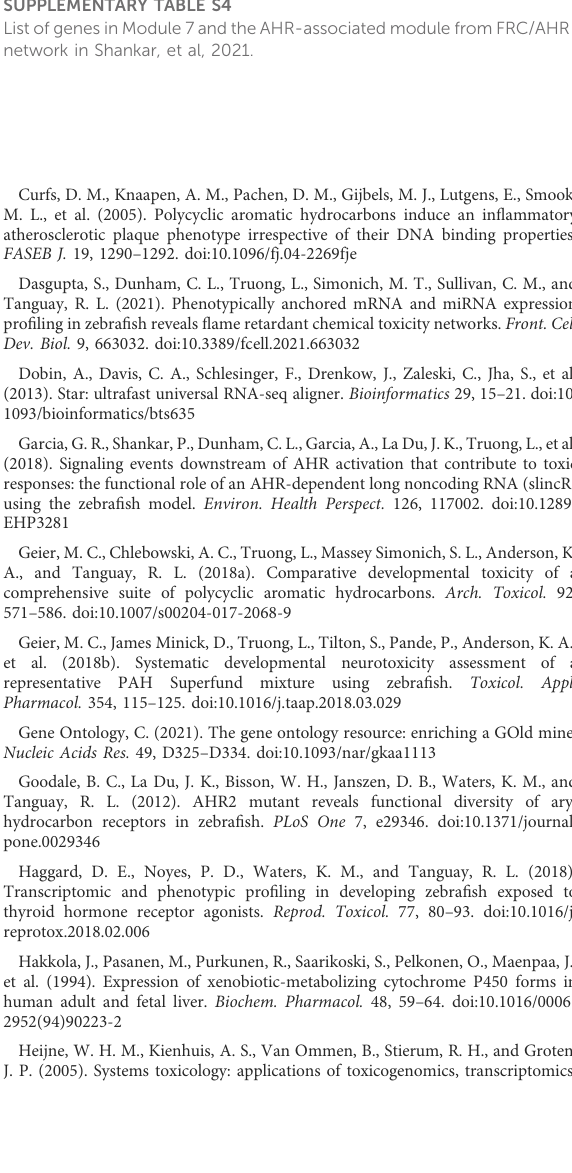
SUPPLEMENTARY TABLE S1 Description of morphological endpoint binning. SUPPLEMENTARY TABLE S2 All morphology data. SUPPLEMENTARY TABLE S3 Edge weight shifts across retene concentration for Module 7 genes. SUPPLEMENTARY TABLE S4 ListofgenesinModule 7and theAHR-associated